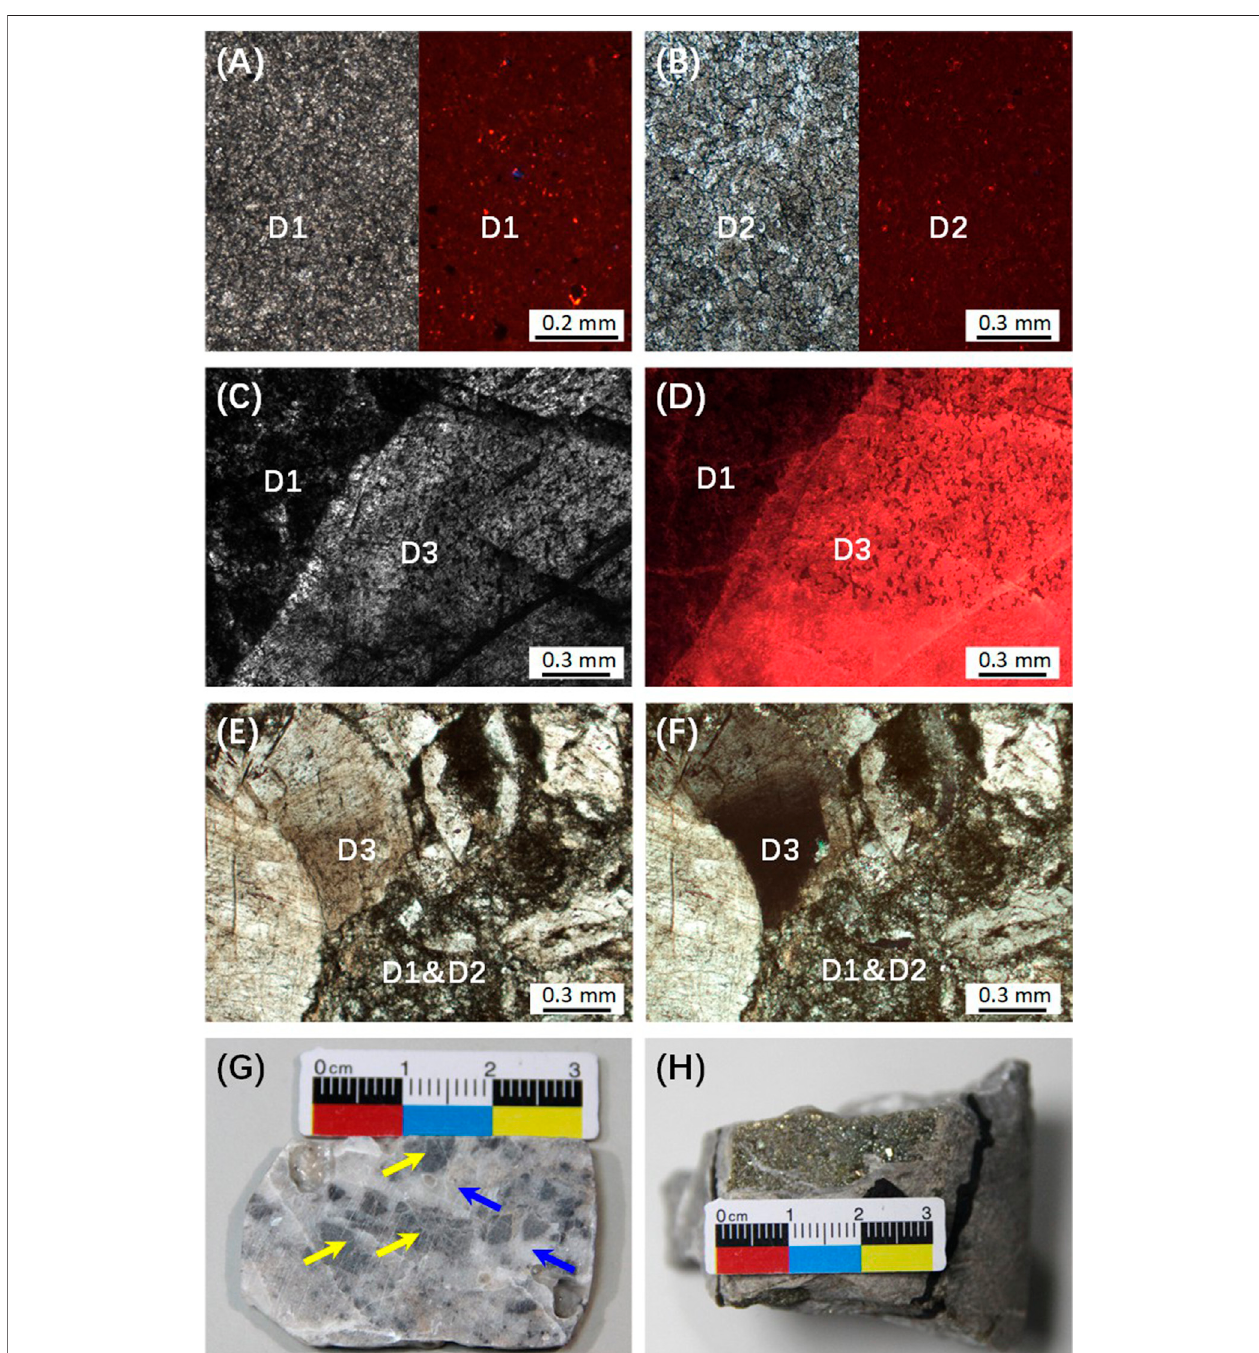
FIGURE 3 | Photomicrographs of the investigated Middle – Upper Cambrian Xixiangchi carbonates. (A) Fine-grained matrix D1 dolomite from sample S1, with a polarized fi gureontheleftandacathodoluminoscope fi gureontheright. (B) Coarse-grainedmatrixD2dolomitefromsampleS17,withapolarized fi gureontheleftanda cathodoluminoscope fi gure on the right. (C) Large-zoned D3 fracture- fi lling dolomite from sample S27 under polarized light. (D) Cathodoluminoscope image of (c). D3 dolomite with undulose (sweeping) extinction under perpendicular polarized light (F) with the same range under plane polarized light (E) . (G) Specimen of fracture- fi lling D3 saddle dolomites(bluearrows) and incorporated breccias ofmatrix D1 and D2 dolomites(yellow arrows) from the fi eld sample. (H) Core sample from well WK1 with pyrite fi lling the fracture (see Figure 1 for well location).